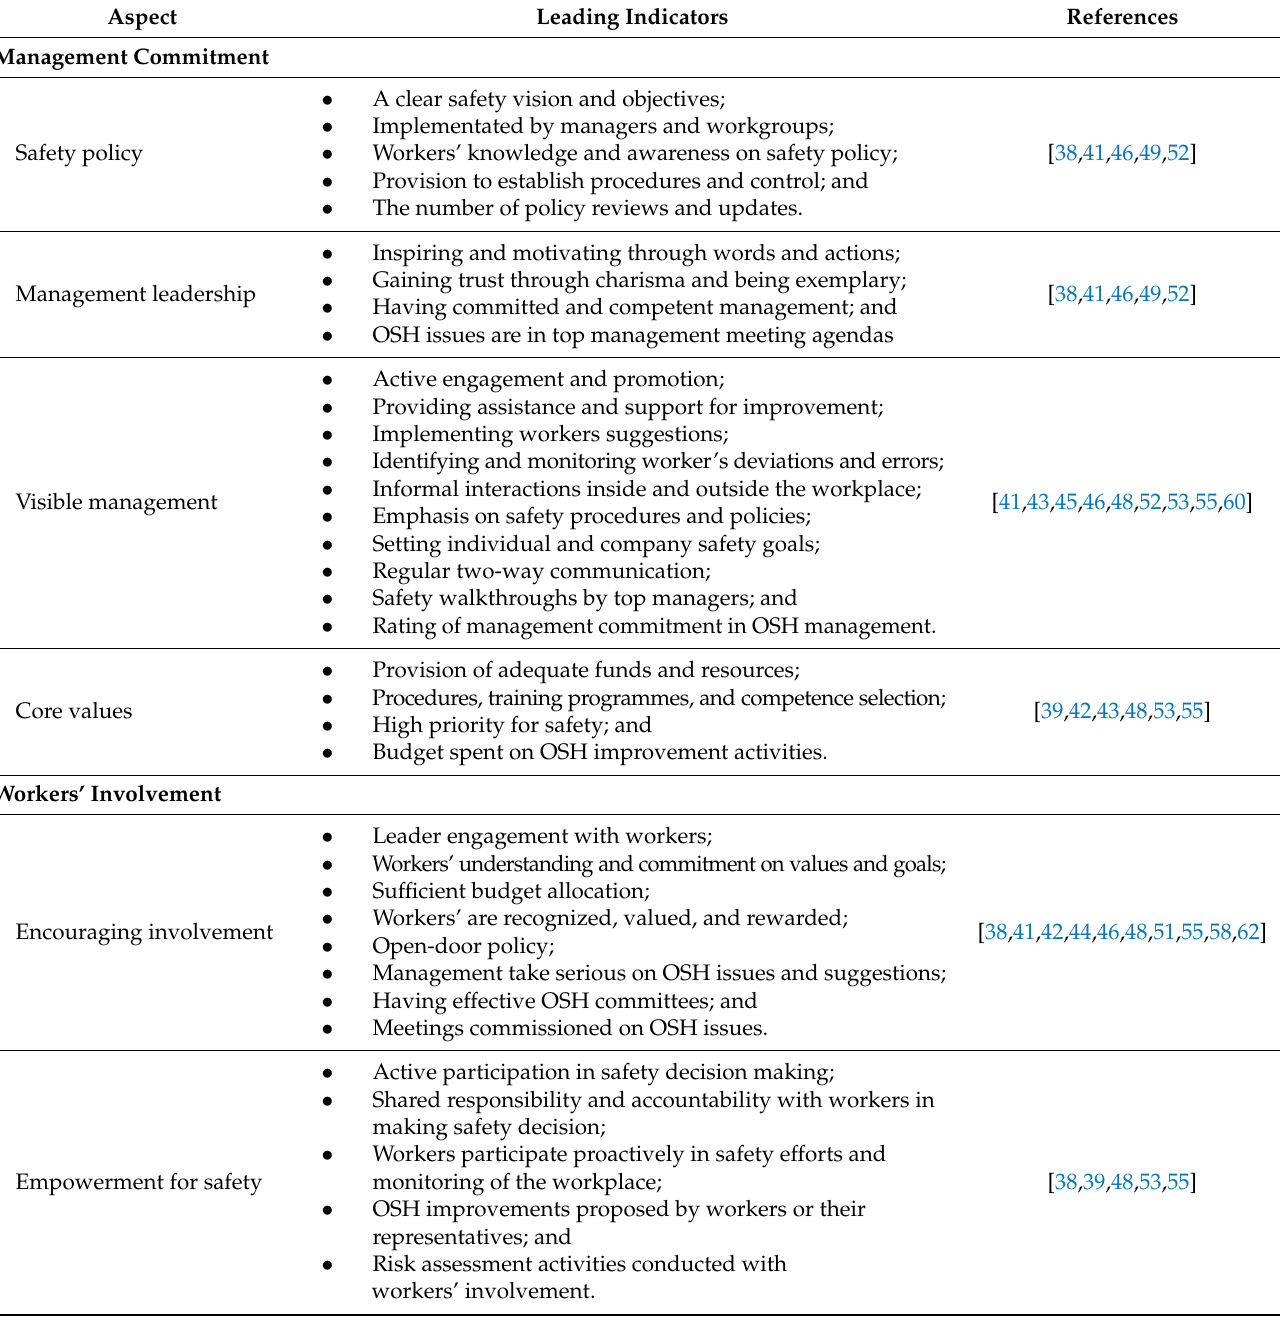
Table 4. Safety management practices leading indicators extracted from reviewed